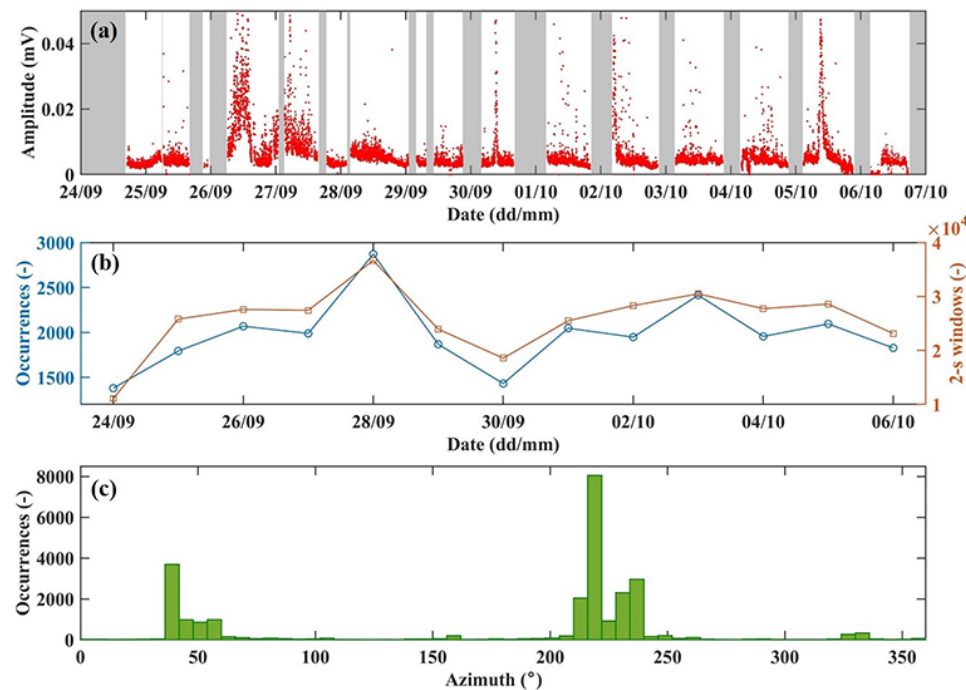
Figure 4. (a) Average amplitude of the recorded 1min ambient seismic noise recordings with indication of data gaps, in grey. (b) Number of 2s windows with strong SW content (in blue) and total number of 2s windows recorded during each day of the survey (in orange). (c) Histogram of the azimuthal directions of the selected windows retrieved from the FDBF method (degrees counterclockwise from E, green reference system in Fig.